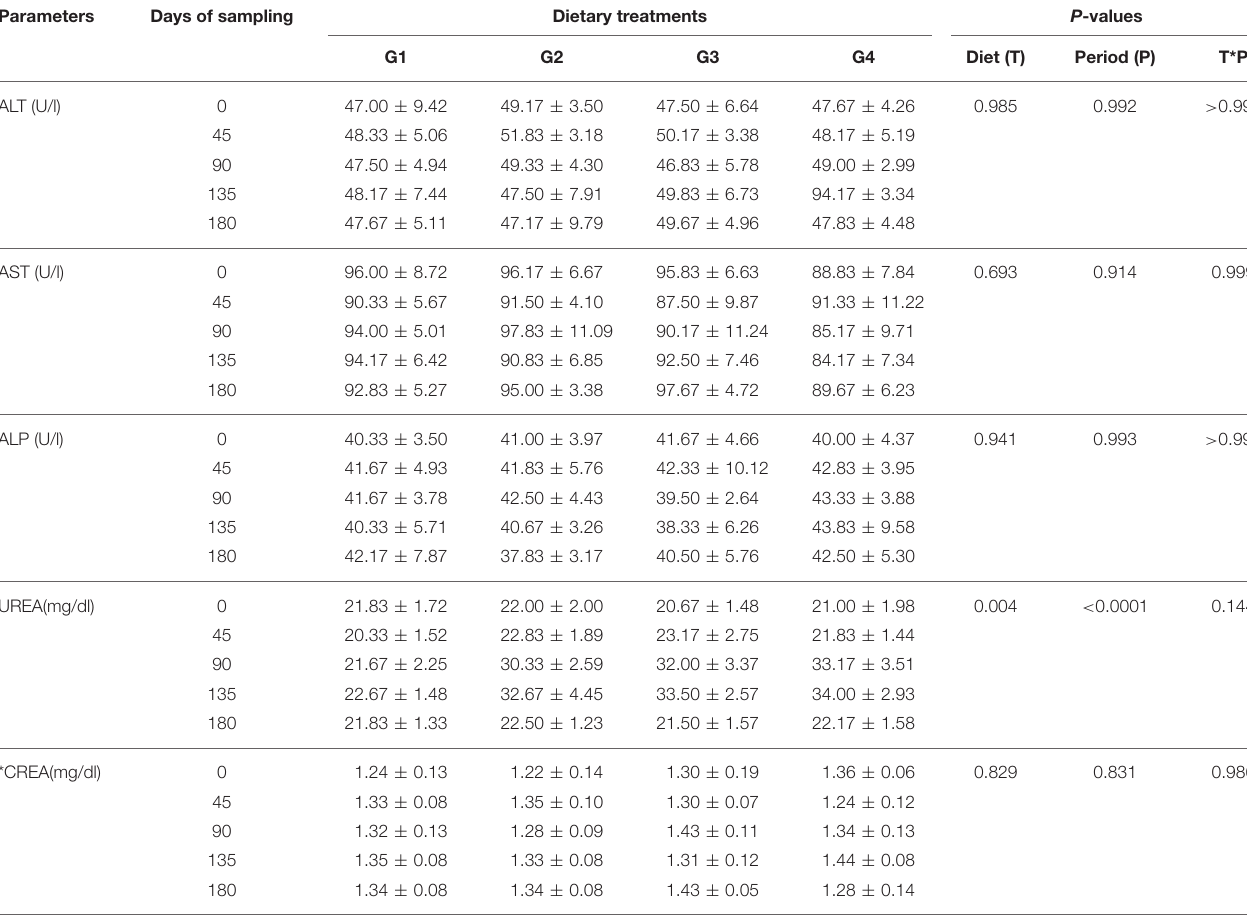
TABLE 3 | Effect of dietary Bt and CP4EPSPS proteins on Serum biochemical response and enzymes activities of male rabbits.